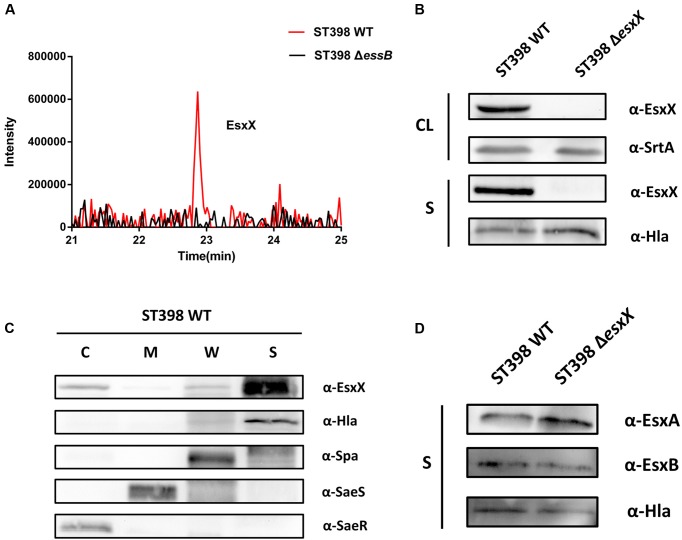
EsxX is a secreted protein of the ESS of ST398 and it has no effect on the secretion of other ESS-secreted factors.
(A) Detection of secreted proteins from ST398 wild type and essB deletion strains by mass spectroscopy. Peaks of peptides derived from EsxX are present in wild type samples but absent in samples from the essB deletion mutant. (B)
S. aureus ST398 cultures were separated into cell lysate (CL) and supernatant (S) fractions. Proteins were detected by Western blotting with specific antibodies (α-EsxX, α-SrtA, α-Hla). (C)
S. aureus ST398 cultures were fractionated into the cytoplasmic (C), membrane (M), cell wall (CW), and supernatant (S) compartments. Proteins were detected by Western blotting with specific antibodies (α- EsxX, α-Hla, α-Spa, α-SeaS, α-SeaR). (D) Supernatant (S) fractions of ST398 wild type and agr mutant cultures were obtained. Proteins were detected by Western blotting with specific antibodies (α-EsxA, α-EsxB, α-Hla).